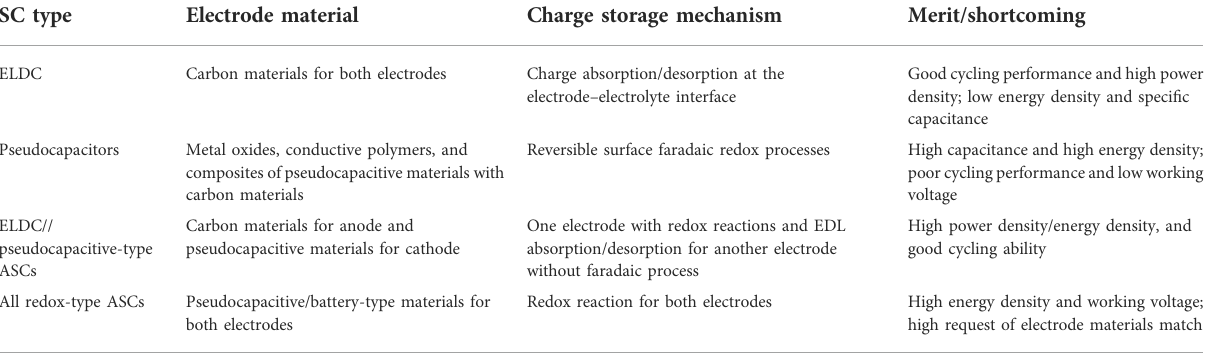
TABLE 1 Comparison of different characteristics of several types of SCs (Li et al.,